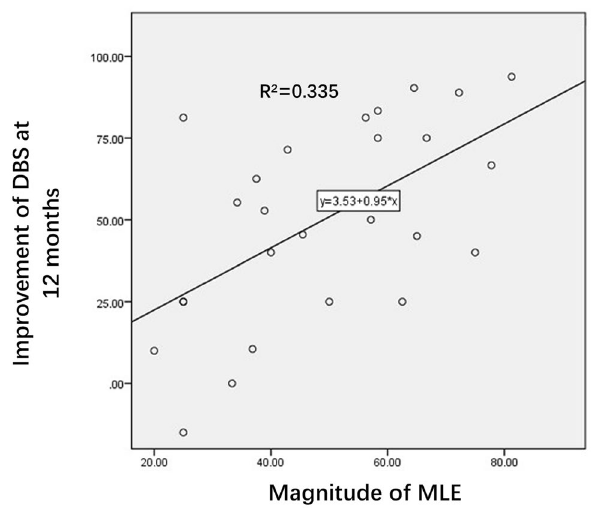
Figure 1. Correlation between the motor score and magnitude of MLE. There was a positive correlation between the improvement of the BFMDRS-M at 12 months following DBS and the magnitude of MLE.